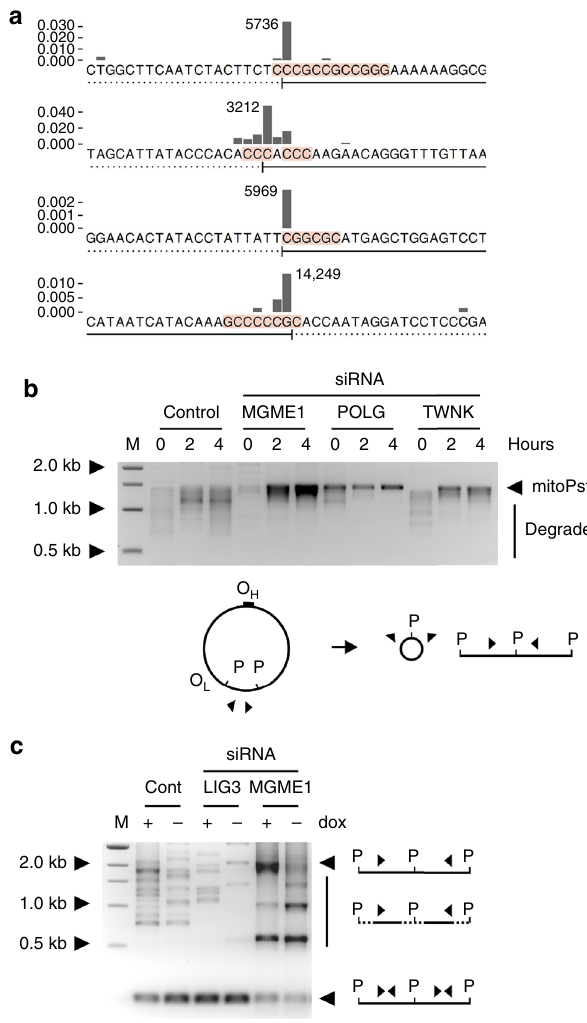
Fig. 5 Rearranged mtDNA molecules in HEK 293 cells expressing mitoEagI or mitoPstI. a Positions of mtDNA breakpoints as detected by ultra-deep sequencing of mtDNA in control cells 6 h after induction of mitoEagI. Continuous lines represent retained parts of the mitochondrial genome. Dotted lines indicate deleted regions in rearranged mtDNA species. Note that the observed breakpoints correspond to frequent ends (cf. Figure 3d). b PCR detection of breakpoints corresponding to non-degraded and partially degraded ends of the 2.1-kb mtDNA fragment in mitoPstI- expressing cells. Ampli fi cation primers MT8282F and MT7682R (Supplementary Table 4) are shown in the scheme as arrowheads. Note that the majority of detected breakpoints correspond to partially degraded mtDNA ends in control cells, while MGME1 , POLG , or TWNK siRNA treatments result in breakpoints mainly corresponding to non-degraded mtDNA ends. The exact positions of representative breakpoints determined by single-molecule PCR and sequencing are shown in Supplementary Table 2. c Concatemers of the 2.1-kb mtDNA fragment in mitoPstI- expressing cells as detected by long-extension PCR 8 using primers MT8194F and MT8387R (Supplementary Table 4). The shortest bands represent ampli fi cation products from unique copies of the 2.1-kb mtDNA fragment (lower arrowhead). Longer PCR products indicate the presence of multimers of the mtDNA fragment corresponding to non-degraded (upper arrowhead) or partially degraded (middle part) ends. Knockdown of the LIG3 gene decreases the abundance of concatemer